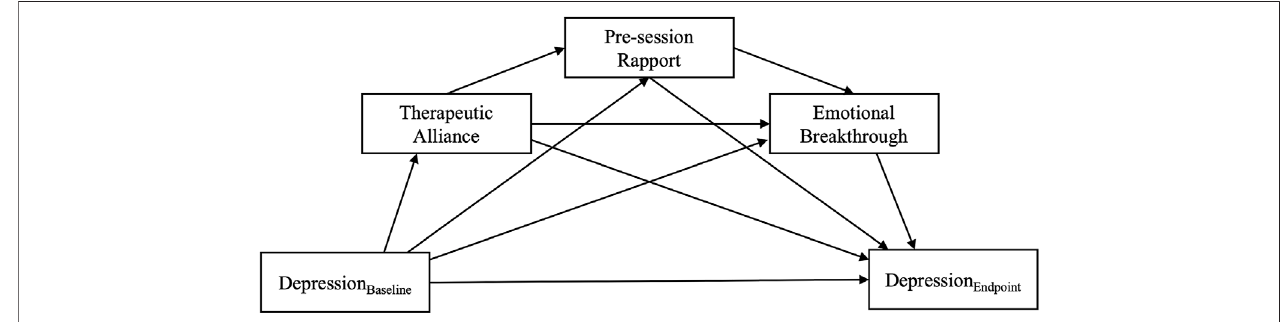
FIGURE 2 | Directed Acyclic Graph (DAG) displaying the path structure of a fully saturated sequential mediation model testing the serial mediation effect of therapeutic alliance on depression outcomes via the active psychedelic experience. The model is completely unrestricted, meaning that all possible paths between all variables are speci fi